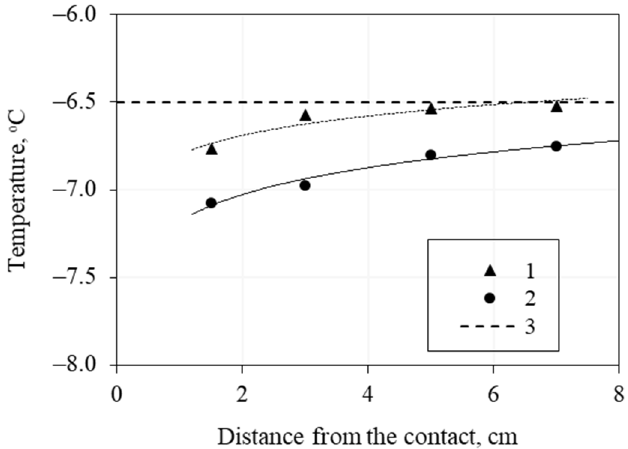
Figure 4. Time-dependent temperature variations in hydrate-free (1) and hydrate-bearing (2) sand after 0.6 h of interaction with a 0.4 N NaCl solution at 0.1 MPa. Dashed line (3) shows initial temperature (t in = − 6.5 ◦ C).